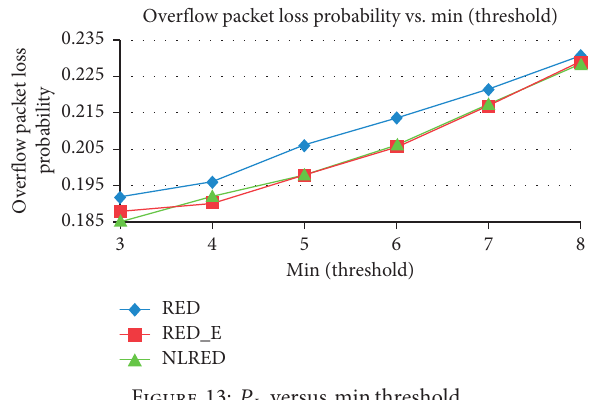
Figure 13: P L versus min